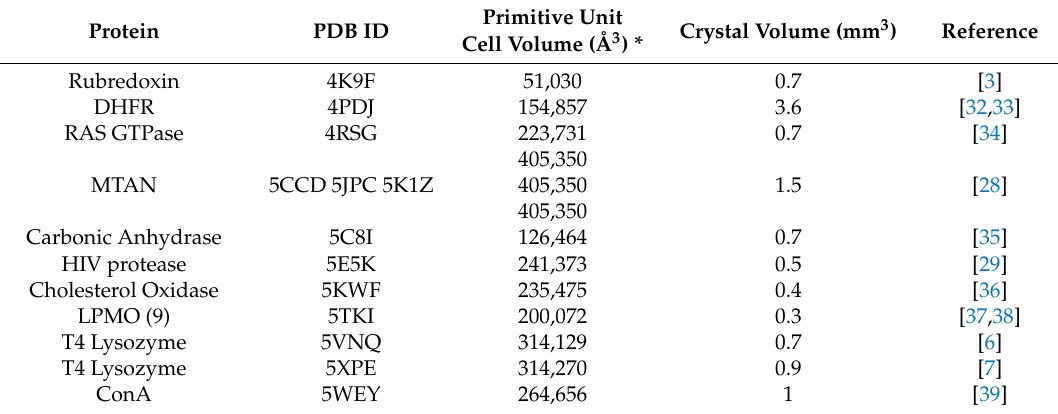
Table 4. Protein structures solved using the IMAGINE instrument. DHFR, dihydrofolate reductase. MTAN, 5 (cid:48) -methylthioadenosine nucleosidase. LPMO, lytic polysaccharide monooxygenase. ConA,